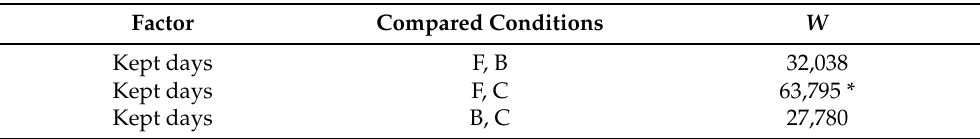
Table 3. Post-hoc Mann–Whitney tests run on the whole sample of participants for the variable “Kept